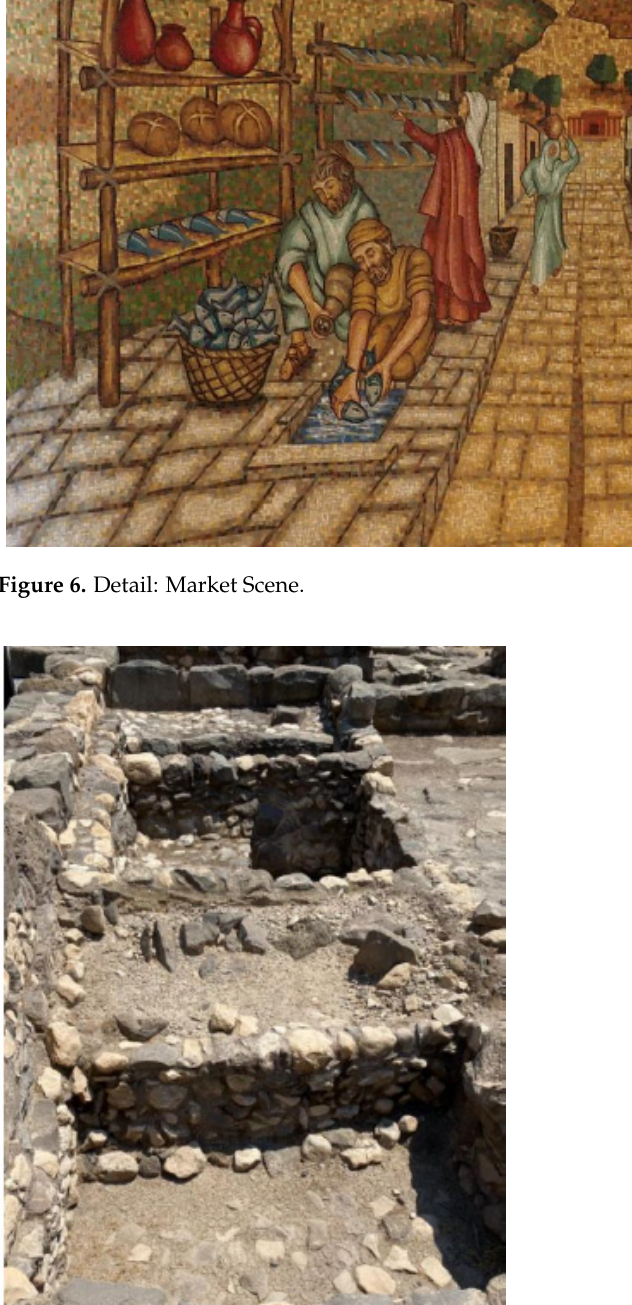
Figure 7. Magdala archaeological site, Salting Pools, 1st Century (photo: Assaf Pinkus).